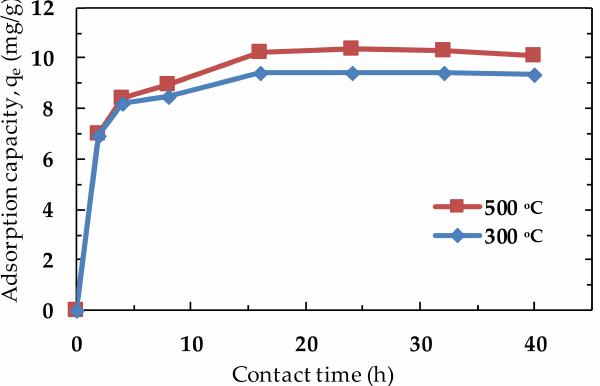
Figure 8. Kinetics of arsenic adsorption by muds obtained by alkali fusion at 300 and 500 °C.